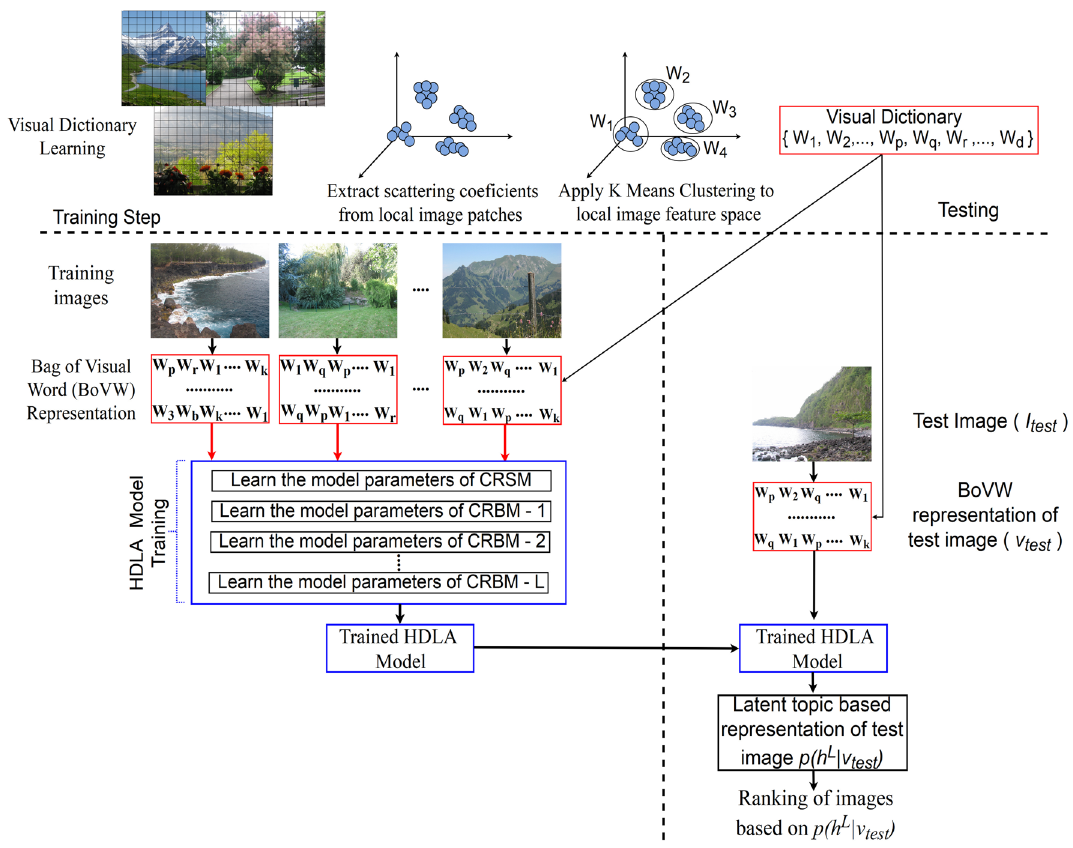
Fig. 6 The proposed HDLA model-based image retrieval